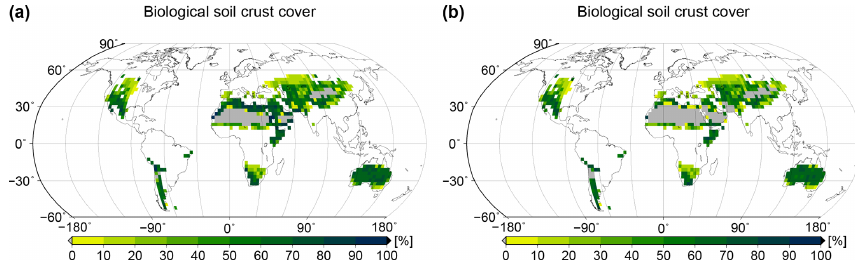
Figure A7. Total biocrust surface cover for (a) doubled dew availability and (b) increased surface resistance to evaporation (from 0 to 100sm − 1